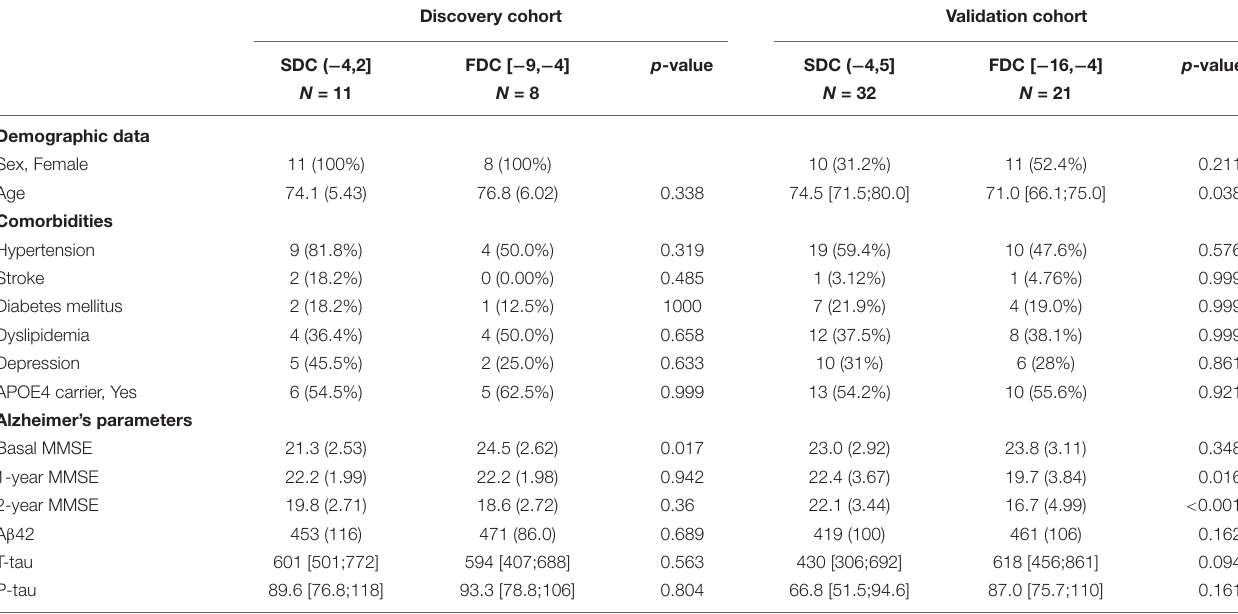
TABLE 1 | Characteristics of the study population that participated in the discovery and validation cohorts. Discovery cohort Validation